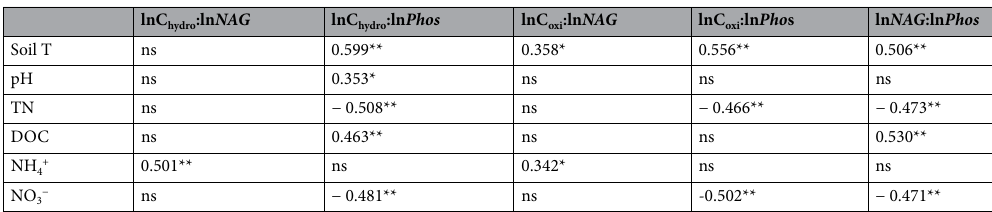
Table 3. Pearson analysis (n = 12) between enzymes ratio and soil physico-chemical properties across the three sampling times. DOC is soil dissolved carbon, NH 4+ and NO 3− are, respectively, soil ammonium and nitrate, SOC and TN are, respectively, soil organic carbon and total nitrogen, pH is soil acidity and SWC is soil water content. ns means no statistical significance and one (*) and two (**) asterisks denote statistical significance at, respectively, 95 ( p < 0.05) and 99% ( p < 0.01) confidence